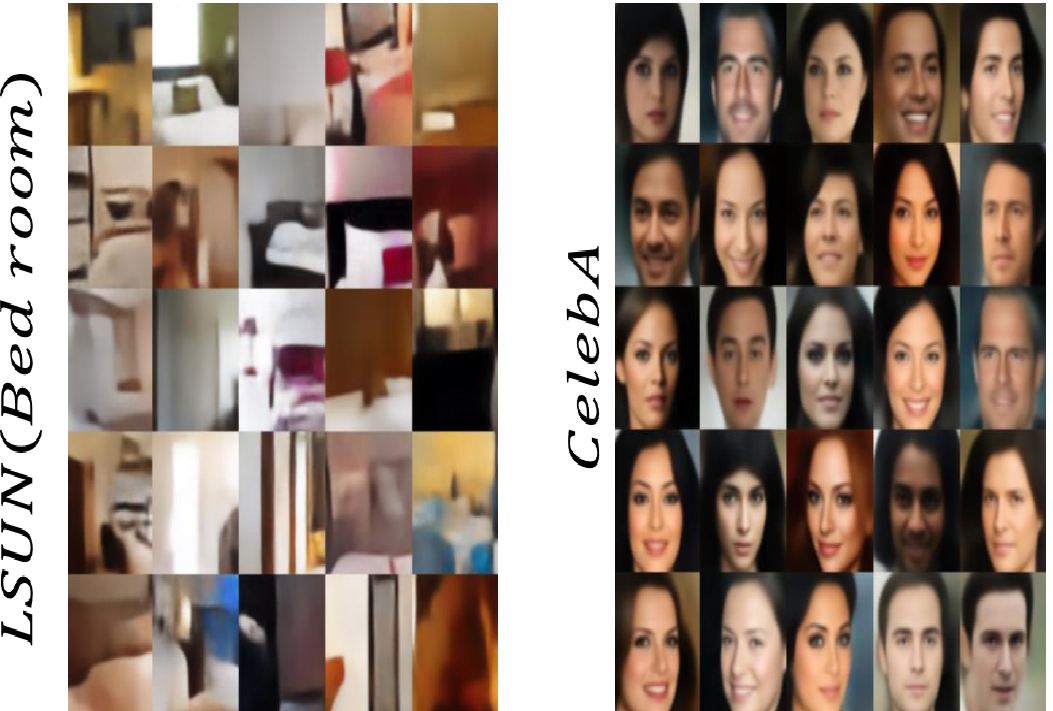
Electronics 2020 , xx , x FOR PEER REVIEW Figure A1. Image generation result of LSUN bedroom and CelebA datasets at 50 epoch.